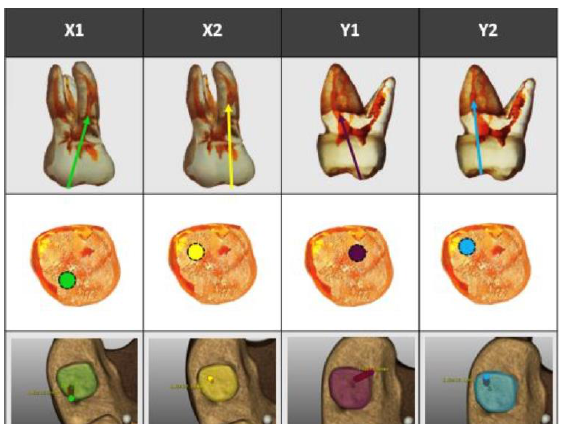
Figure 1. Four different point endodontic access cavities (PEACs) are shown by illustrating for each tooth the planned trajectory, the insertion of the burr on the occlusal surface and 3D rendering of the